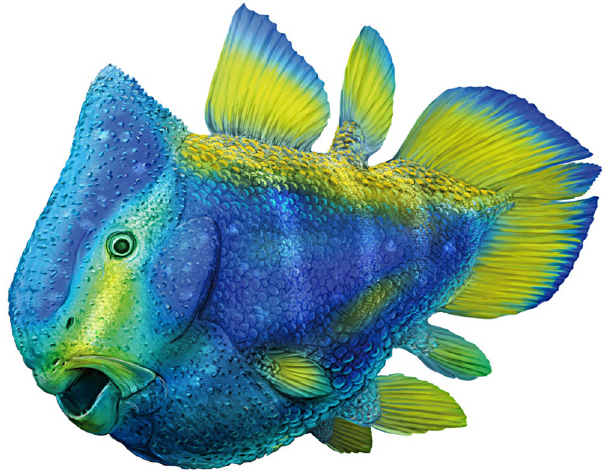
Figure 4. Reconstruction of the living coelacanth Foreyia maxkuhni gen. et sp. nov. Artwork by Alain